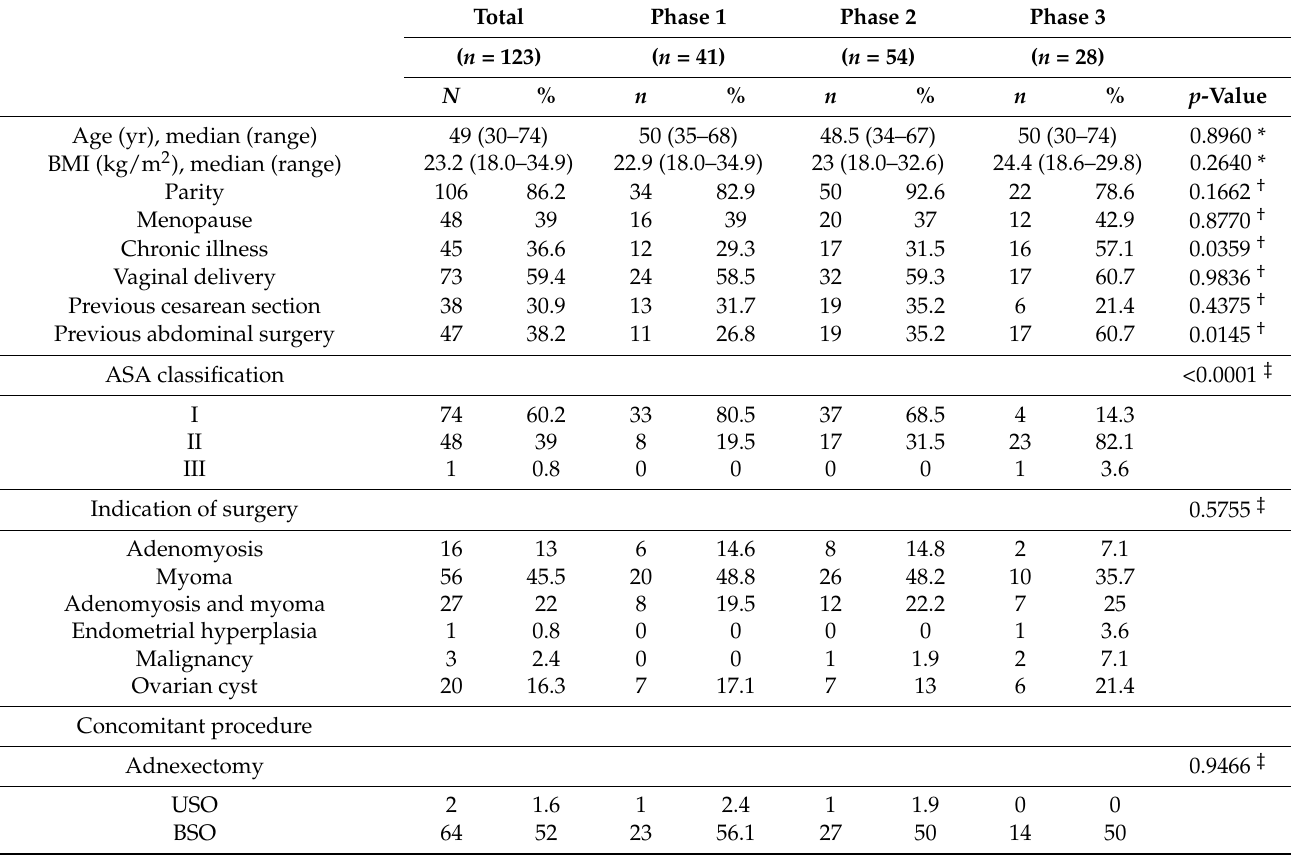
Table 1. Characteristics of patients who were underwent single-port robotic surgery.